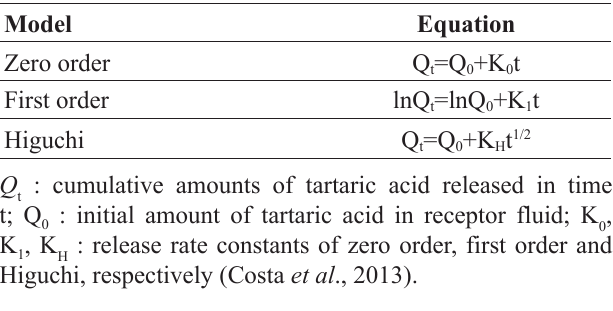
TABLE II - Kinetics of drug